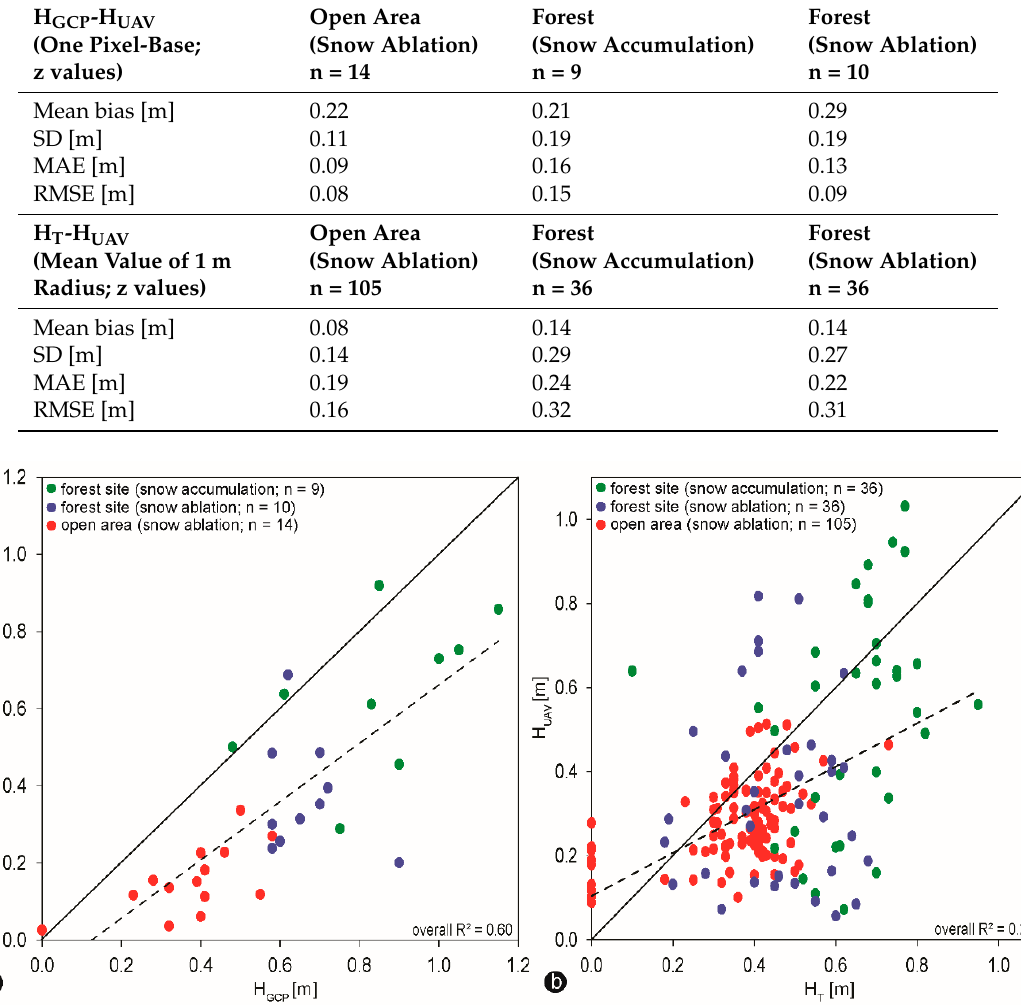
Figure 7. ( a ) Snow depth measured by UAV (H UAV ) compared to the reference snow depth measured at GCP positions (H GCP ) at all study sites. ( b ) Snow depth measured by UAV (H UAV ) compared to the reference snow depth measured in a denser network (H T ) at all study sites. The dataset in (b) features a significantly higher snow depth variability (R 2 = 0.20) than dataset formed by snow depth measurements taken at GCP positions (R 2 = 0.60). Graphs show the regression functions (dashed lines) and 1:1 correspondence (solid lines).